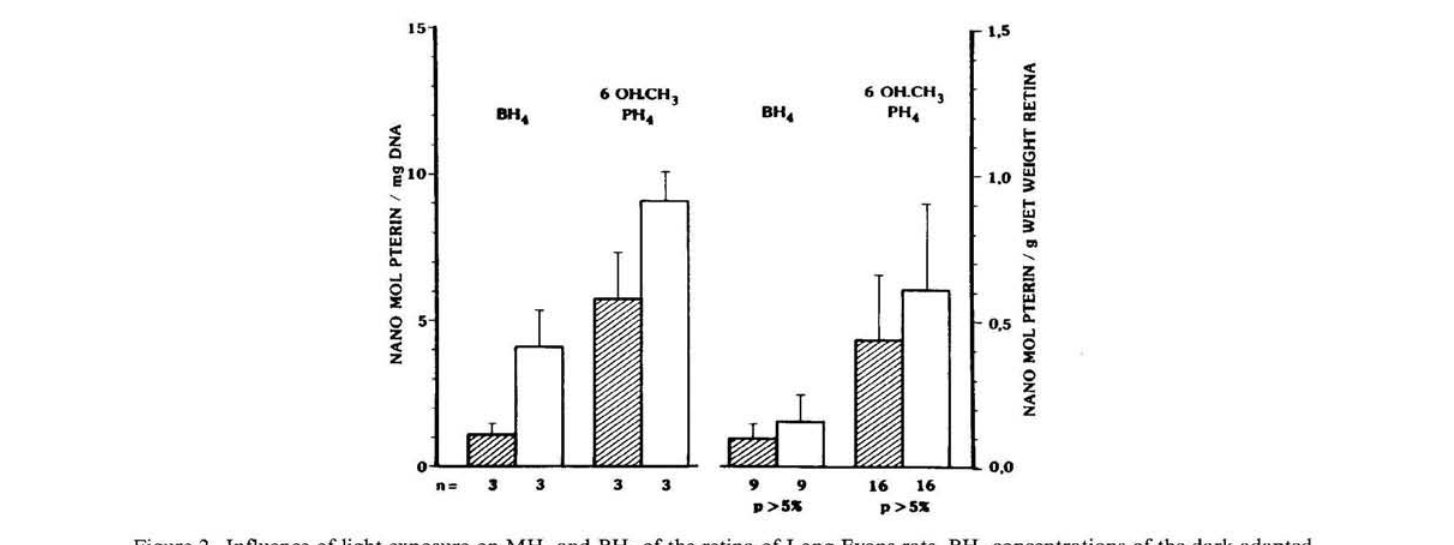
Figure 2. Influence of light exposure on MH 2 and BH 4 of the retina of Long Evans rats. BH 4 concentrations of the dark adapted retinas were below the detection limit(*). Electrochemical detection: 800 mV, 1 nA. The dark and light columns indicate dark and light illumination